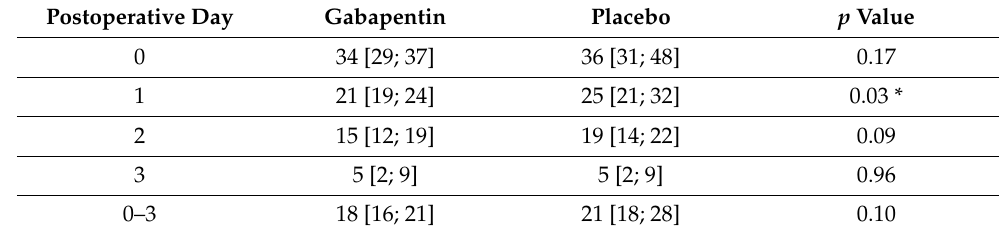
Table 3. Morphine consumption (mg) in the gabapentin group ( n = 28) and the placebo group ( n =